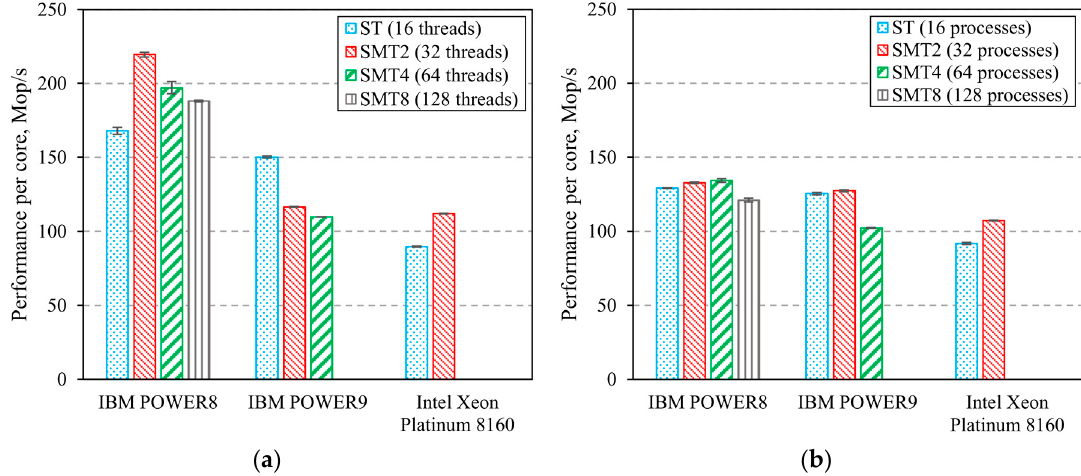
Figure 9. IS benchmark results: OpenMP version ( a ) and MPI version ( b ).